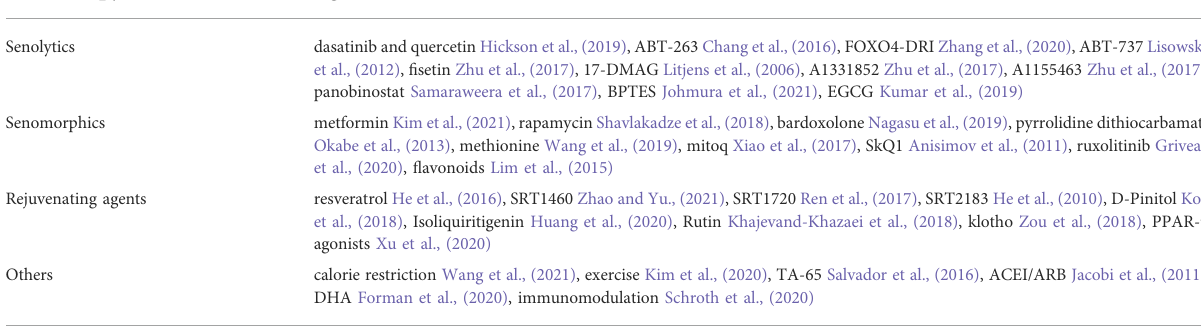
TABLE 2 Therapeutic approaches against cellular